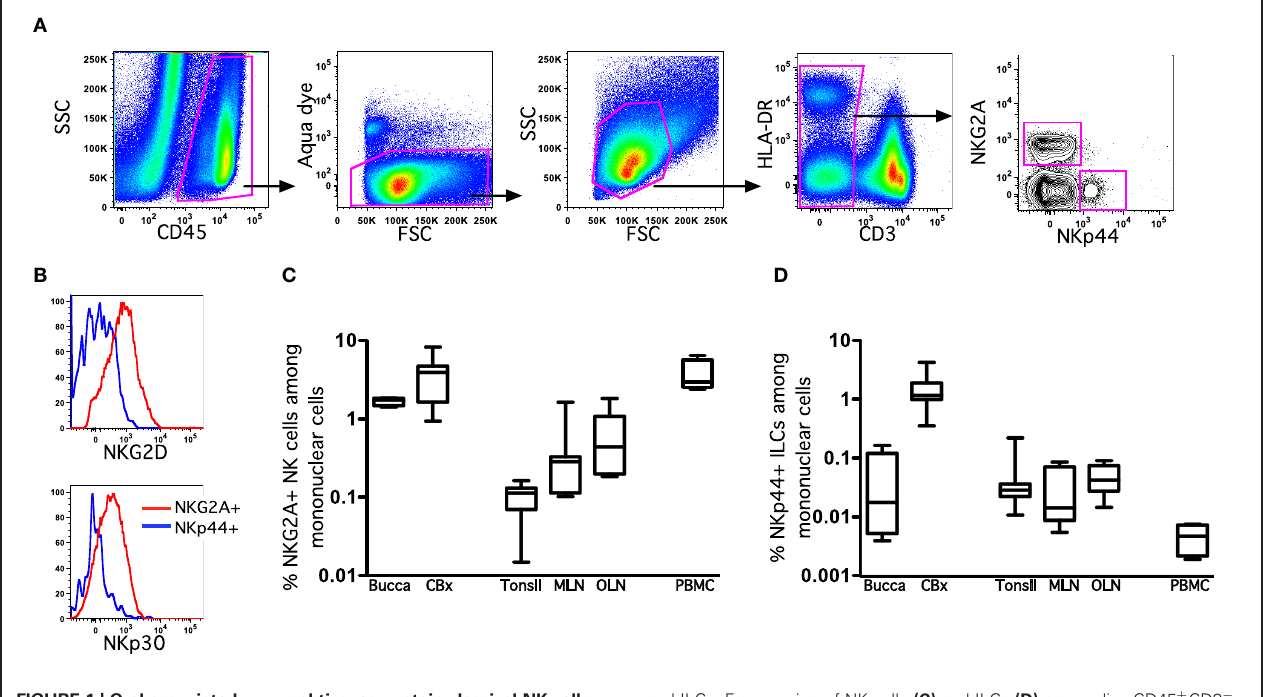
FIGURE 1 | Oral-associated mucosal tissues contain classical NK cells and innate lymphoid cells. (A) Representative gating strategy to identify NKG2A + NK cells and NKp44 + ILCs among live mononuclear cells. (B) Representative histograms of NKG2D and NKp30 expression on NK cells